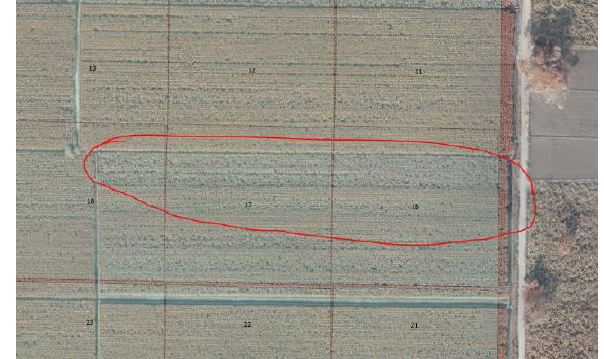
Figure 11. Non-Uniform sowing pattern by labor